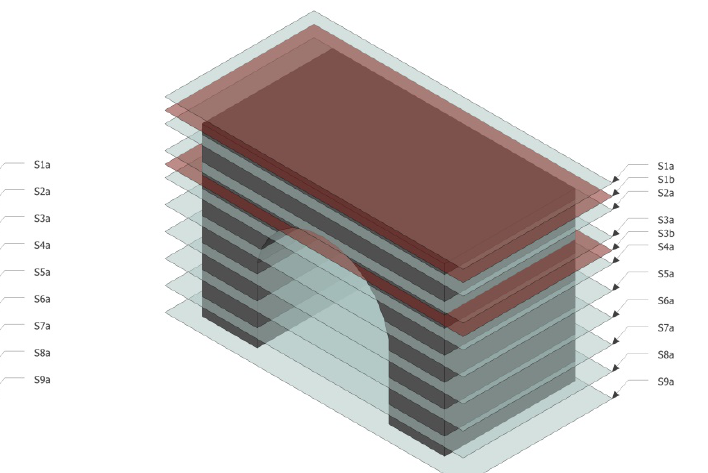
Figure 4. Visualization of the stacking layer concept